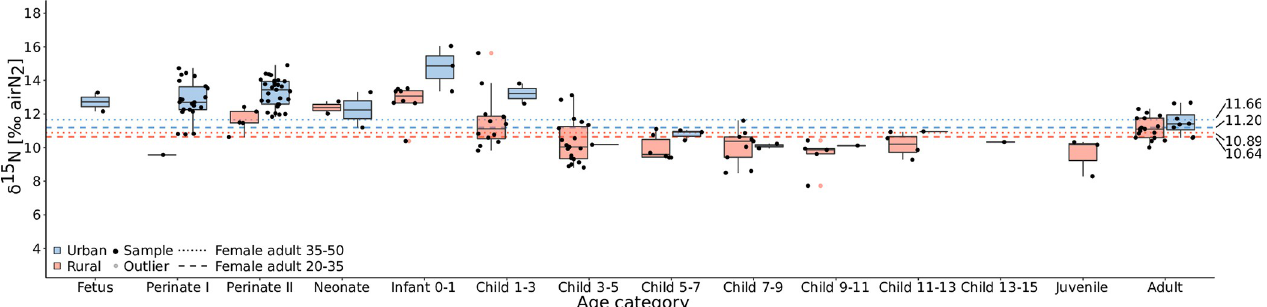
Fig 5. Boxplot of the δ 15 N values of rural and urban children. The blue color indicates urban individuals, while the pink color indicates rural individuals. The non-adult values were plotted against the mean δ 15 N values of the urban and rural female individuals at the age of 20–35 and 35–50 years, indicated in the graph with the blue and pink dotted and dashed lines. The children in the 1–7 and 7–15 categories were further divided into smaller 2-years groups to provide higher resolution to the data. Statistical outliers have been determined for each age group according to the IQR criterion.